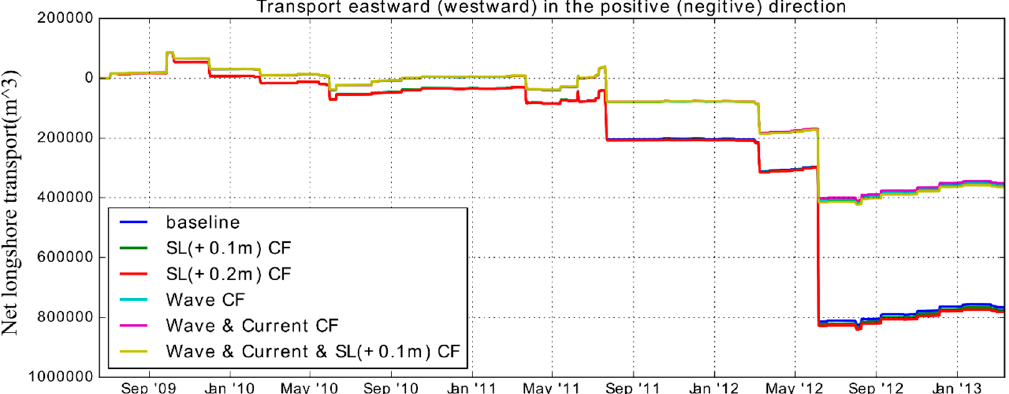
Figure 6. Time series of net longshore transport Q T δ (m 3 ) from different TELEMAC downscaled climate change factor (CF) forcing. This plot has the same format as Figure 5. The legend indicates which change factor (CF) sensitivity forcing has been applied, along with the baseline transport. SL is the sea level increase (0.1 or 0.2 m).